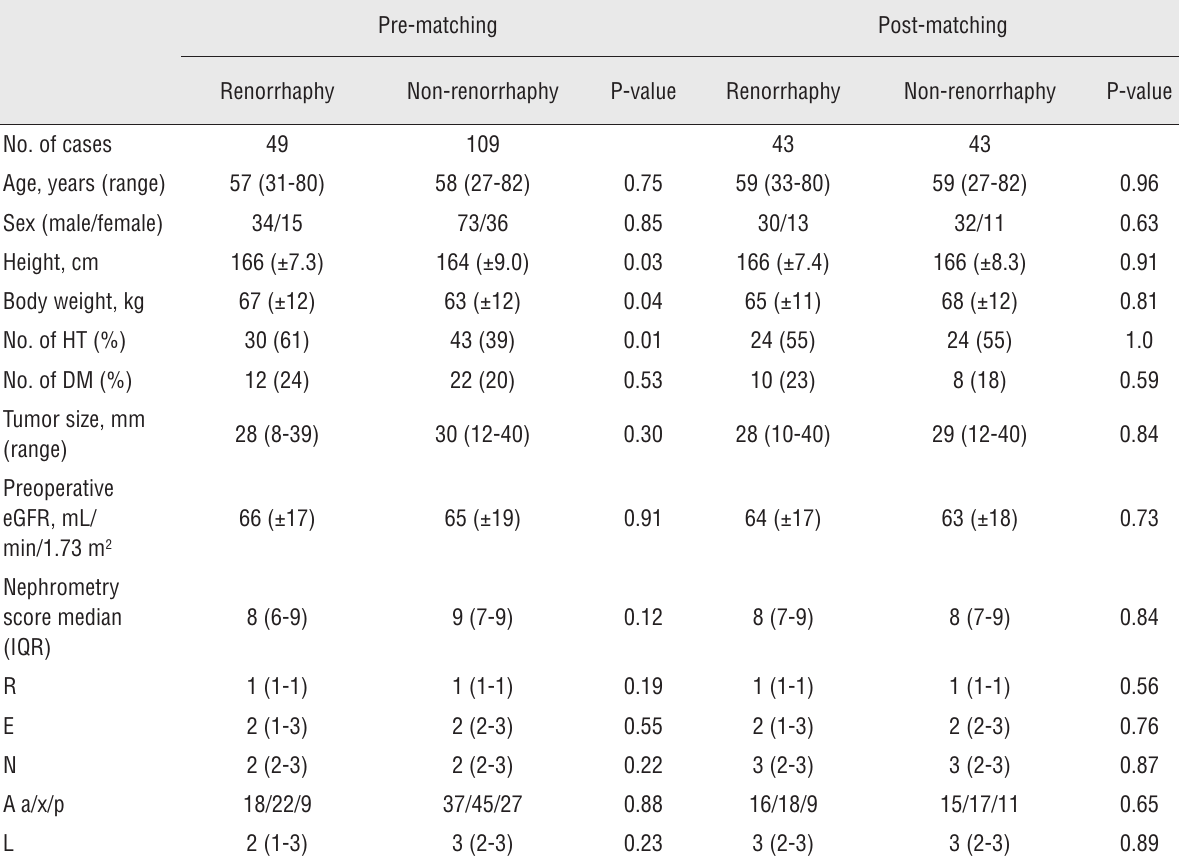
Table 1 - characteristics of patients undergoing open partial nephrectomy pre- and post-matching.